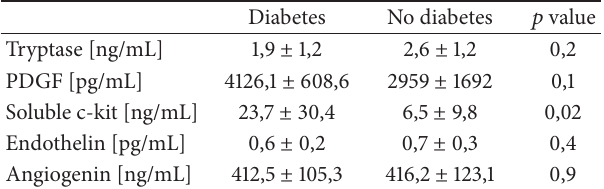
Table 5: The differences in tryptase, PDGF, soluble c-kit, ET-1, and angiogeninlevelsbetweendiabeticandnondiabeticSTEMIpatients. The analysis was made using 𝑡 -test. Diabetes